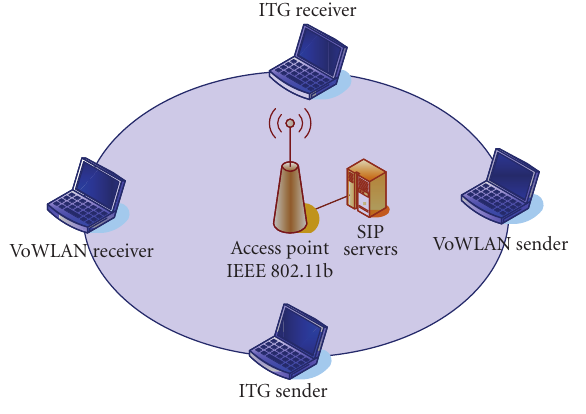
Figure 4: Measurement setup.